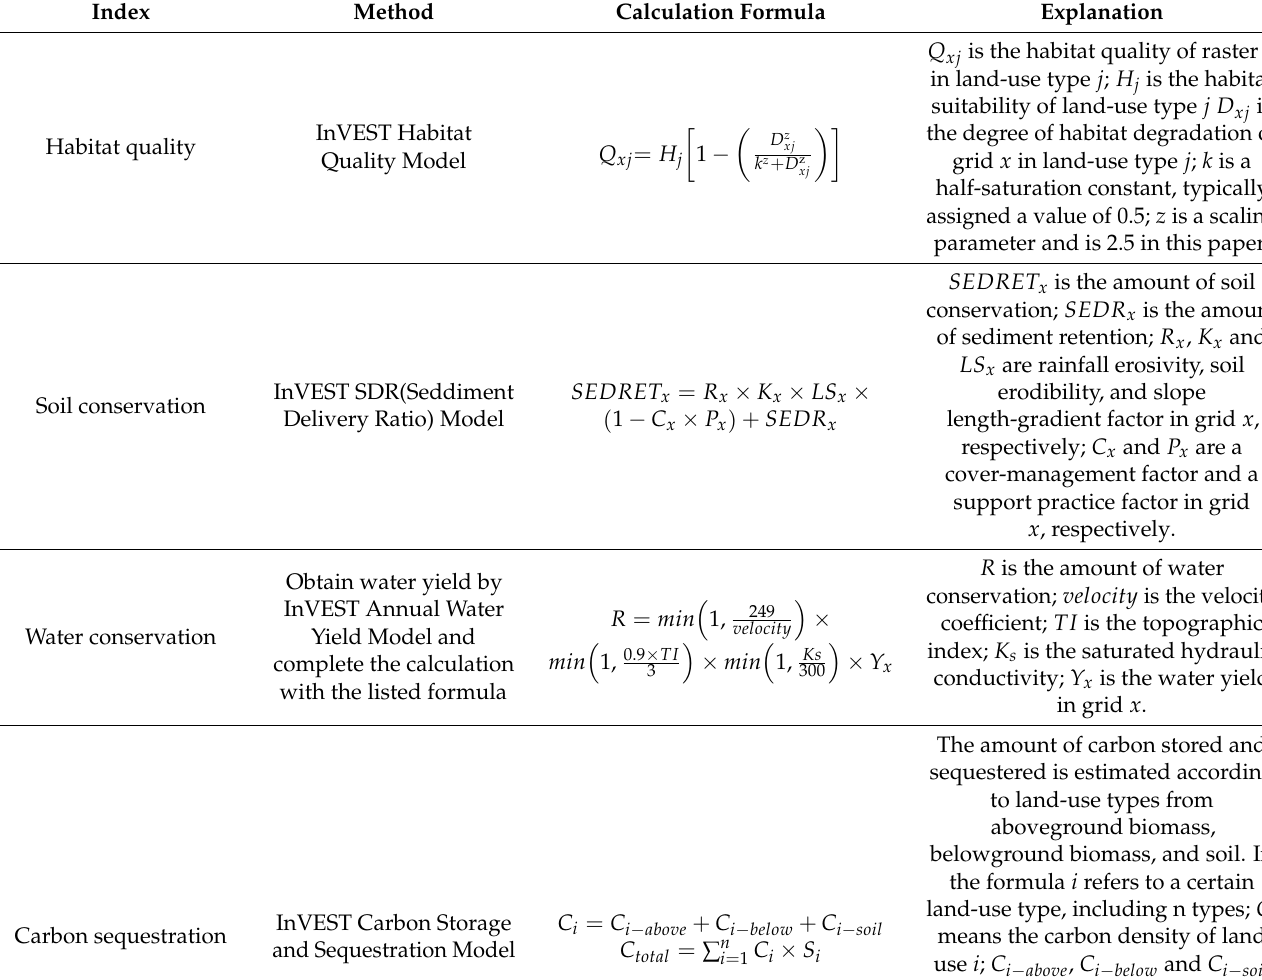
Table 2. Methods and calculation processes for ecosystem-service